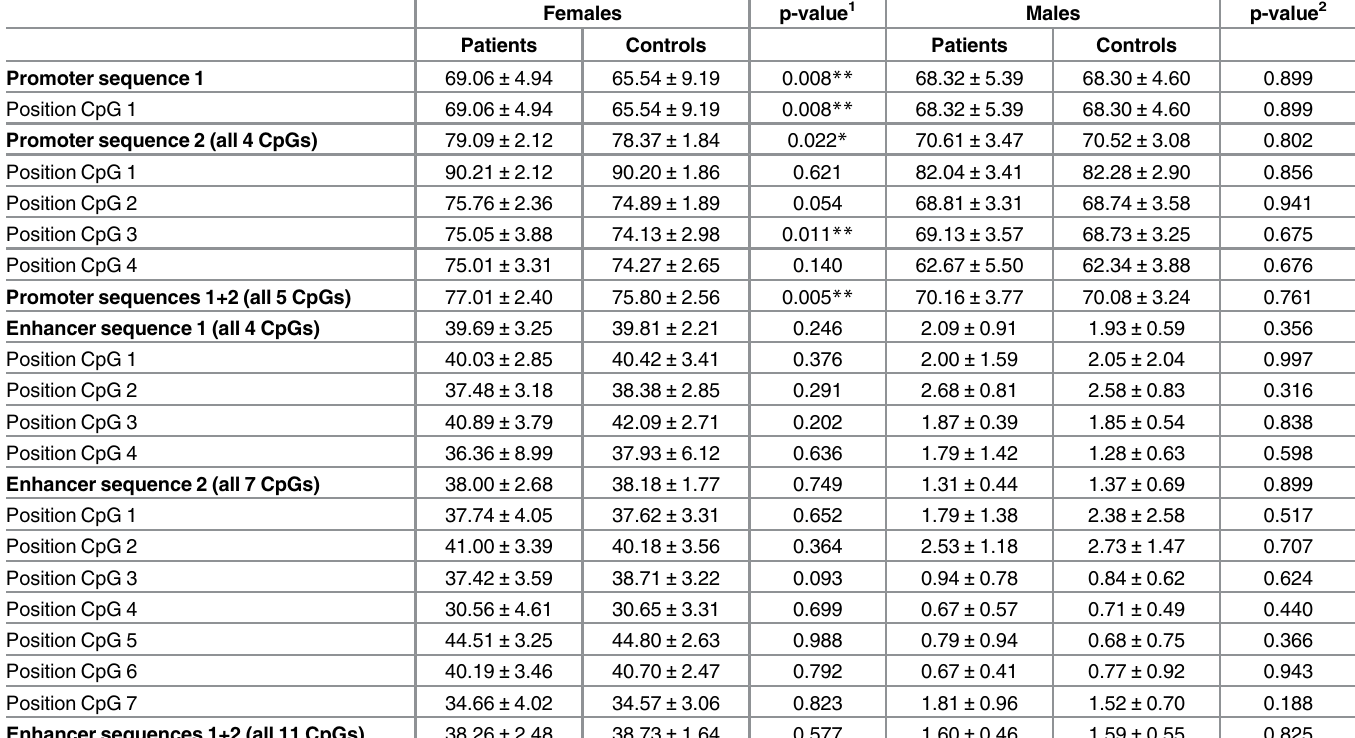
Table 4. Methylation of FOXP3 Promoter and Enhancer